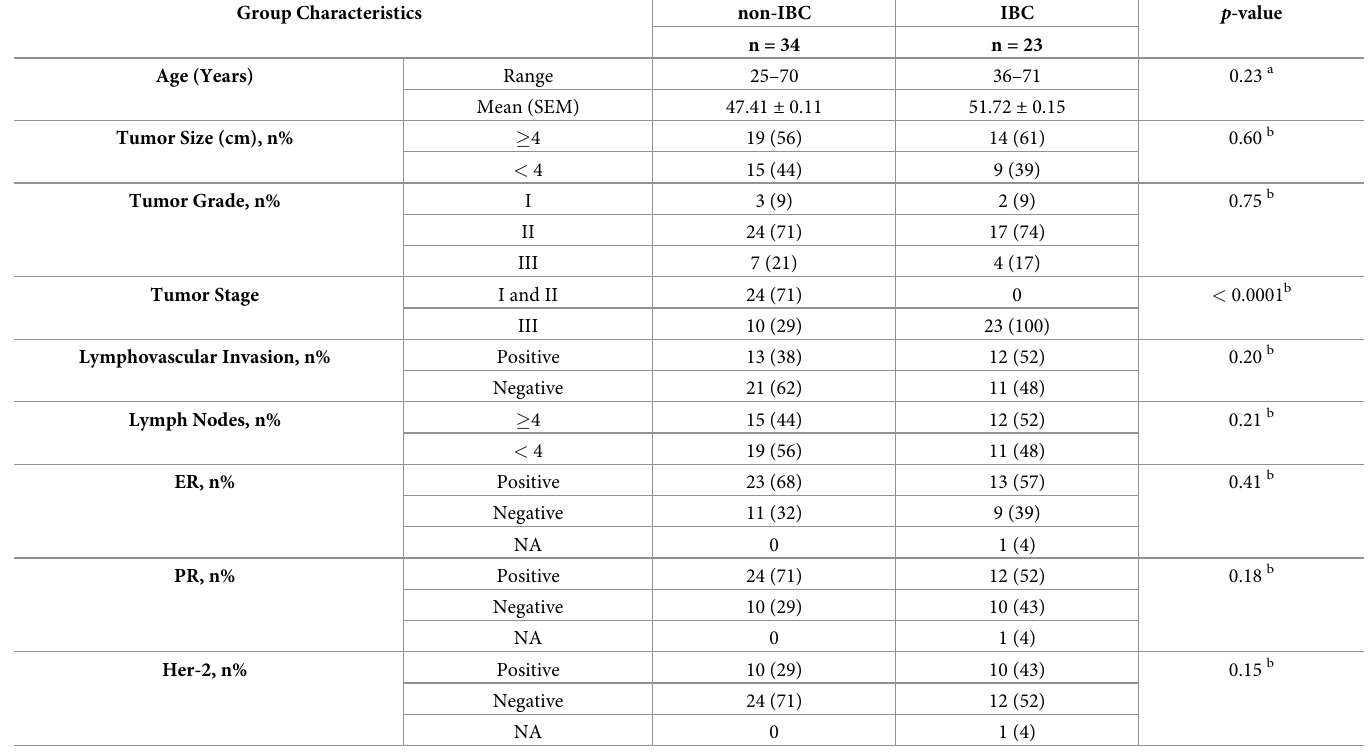
Table 2. Clinic-pathological features of non-IBC and IBC patients. Group